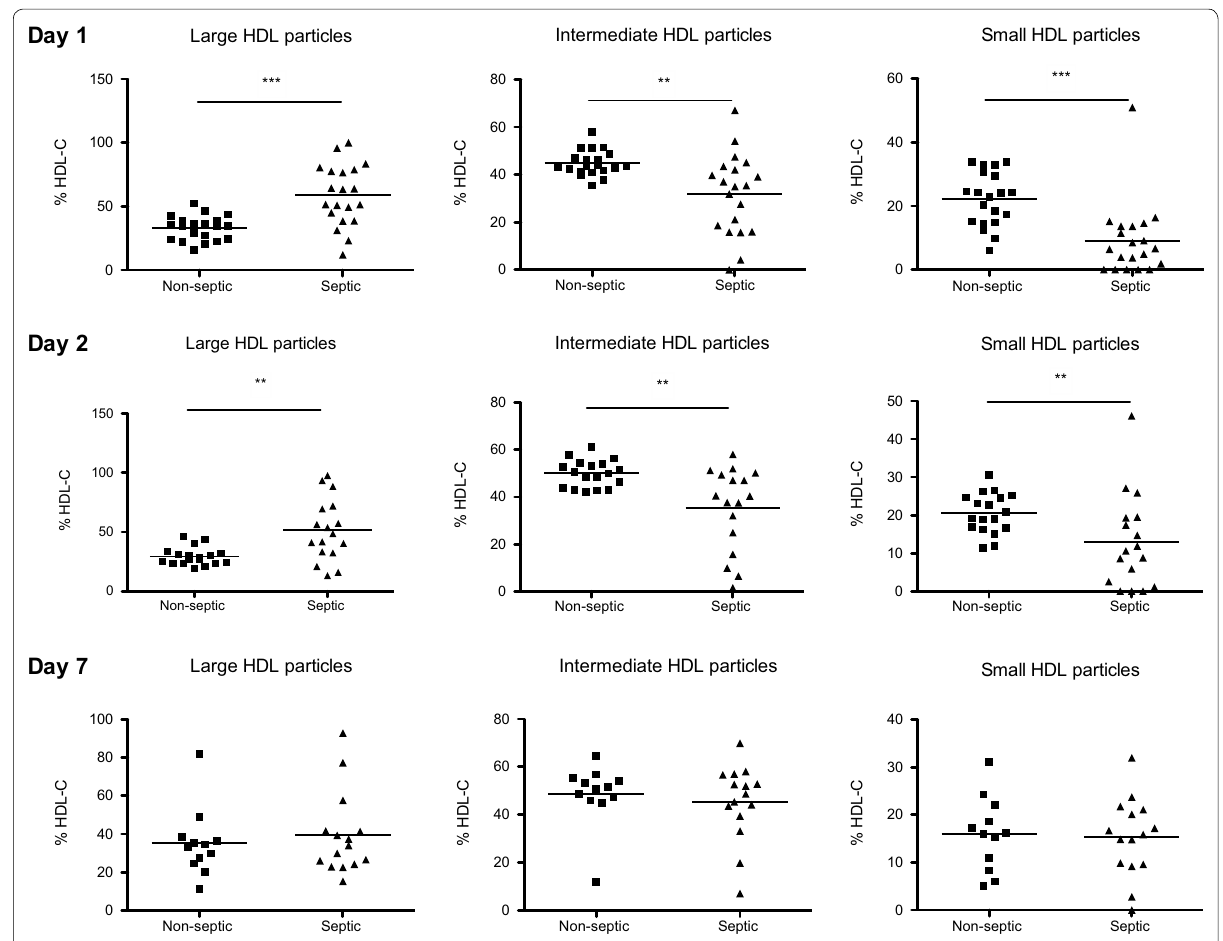
Fig. 1 Lipoprint analysis of HDL particle size. Distribution of the different HDL subfractions (large, intermediate and small) in plasma of septic patients and non‑septic patients at day 1, day 2 and day 7. The results are presented as percentages of total cholesterol detected in HDL fractions. * p < 0.05, ** p < 0.01, *** p < 0.001